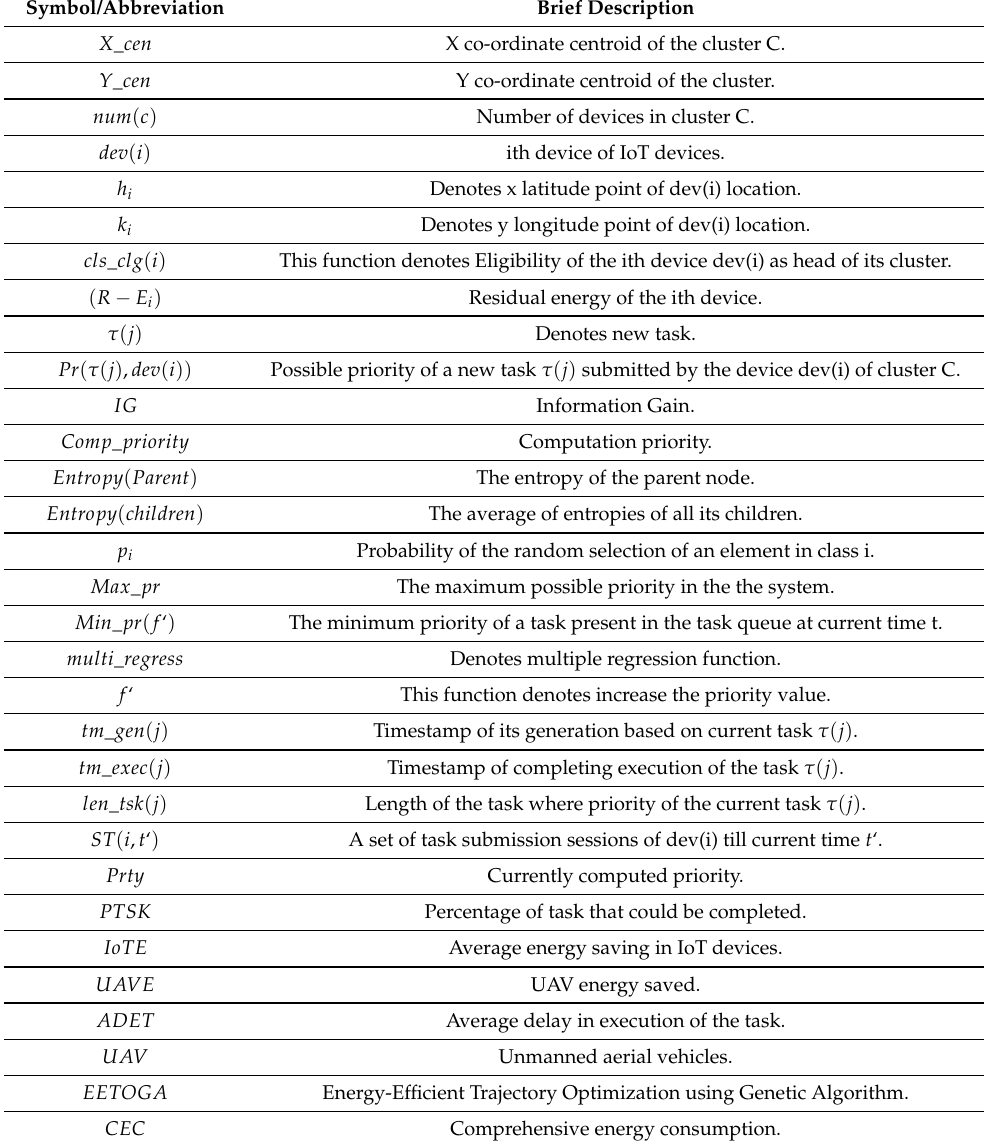
Table 1. Symbols, Abbreviation, and their